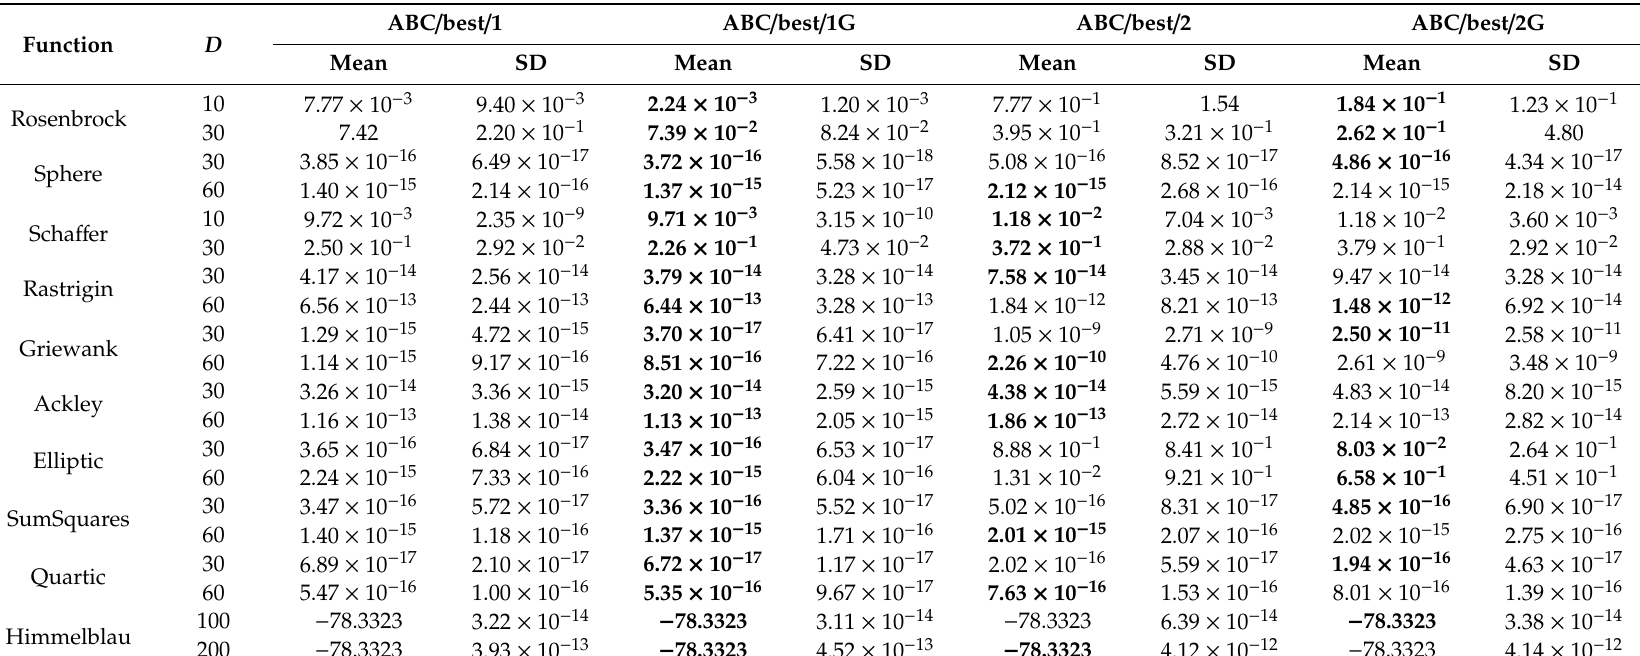
Table 5. Optimization results of ABC / best / 1, ABC / best / 1G, ABC / best / 2, and ABC / best /